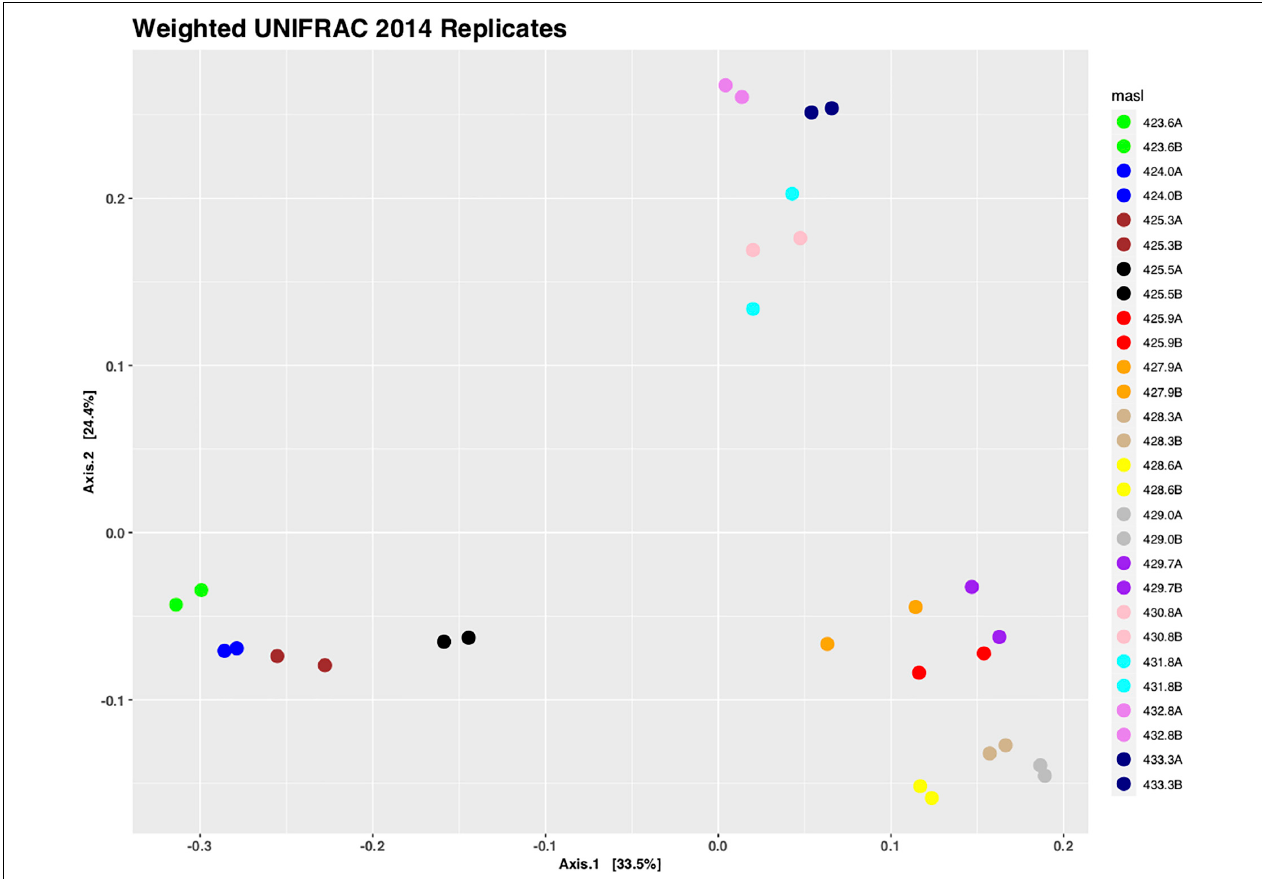
FIGURE 3 | Principal coordinate analysis (PCoA) of weighted UniFrac distances of replicate samples taken from core 1407. Replicate samples are shown in identical colors and sample names are based on the depth they were taken from. Replicates group closely together using PERMANOVA ( R 2 = 1, p =